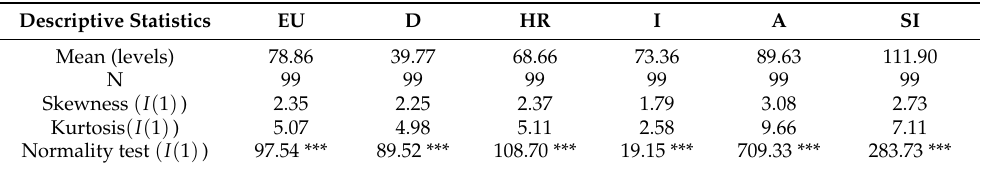
Table A5. Descriptive statistics of price indices in the hospitality industry (base 2015), data